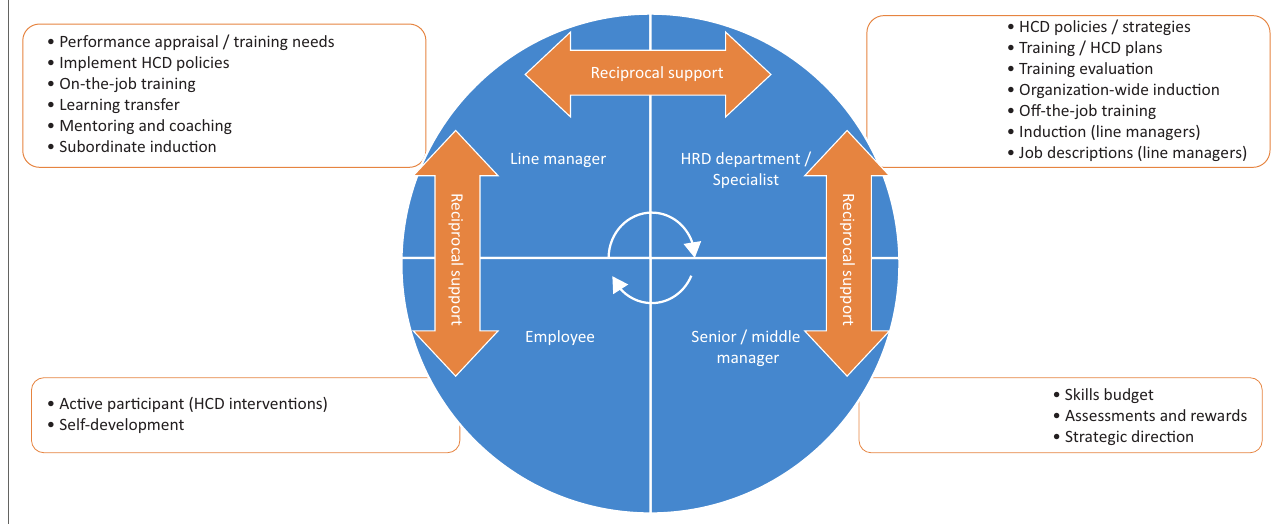
FIGURE 1: Proposed reciprocal support for human capital development stakeholders’